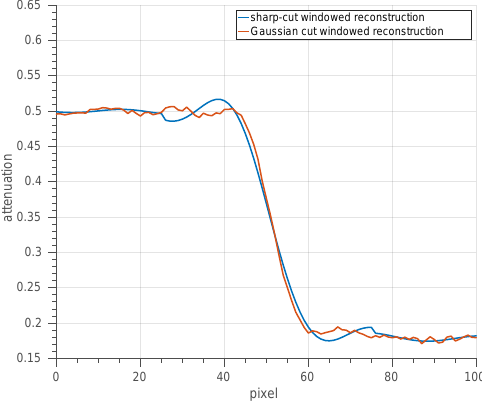
Figure 8. Lineplots of the edge of the step wedge in Figures 4a and